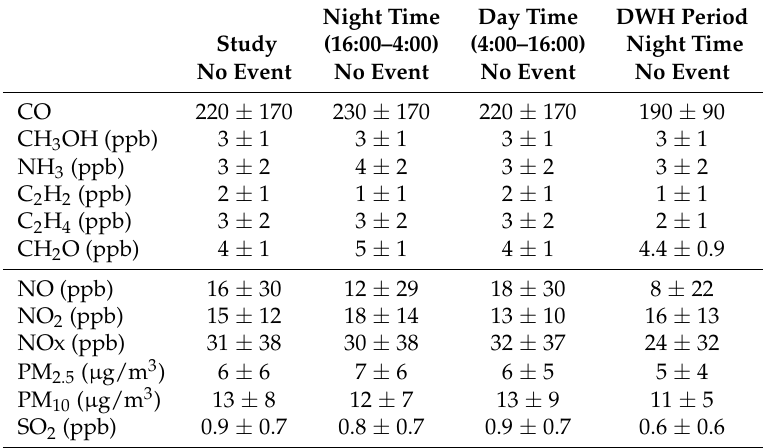
Table A1. Different background concentrations tested in calculation of enhancements.